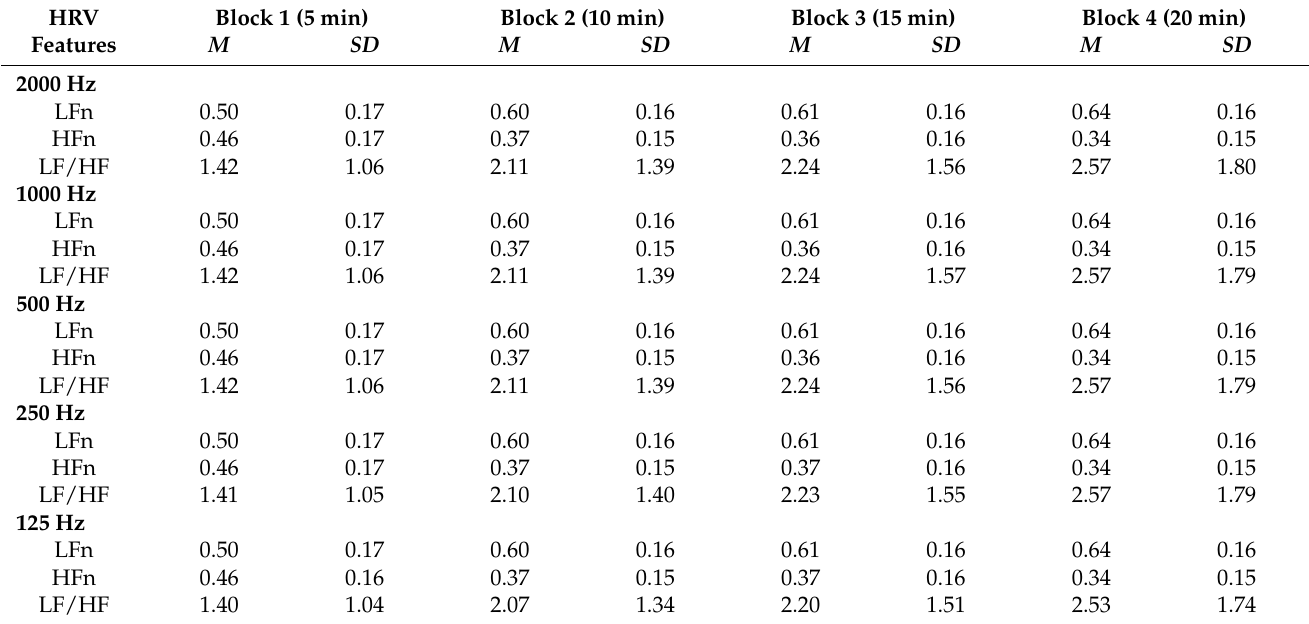
Table 1. Descriptive statistics of the frequency-domain heart rate variability features across different sampling rates.